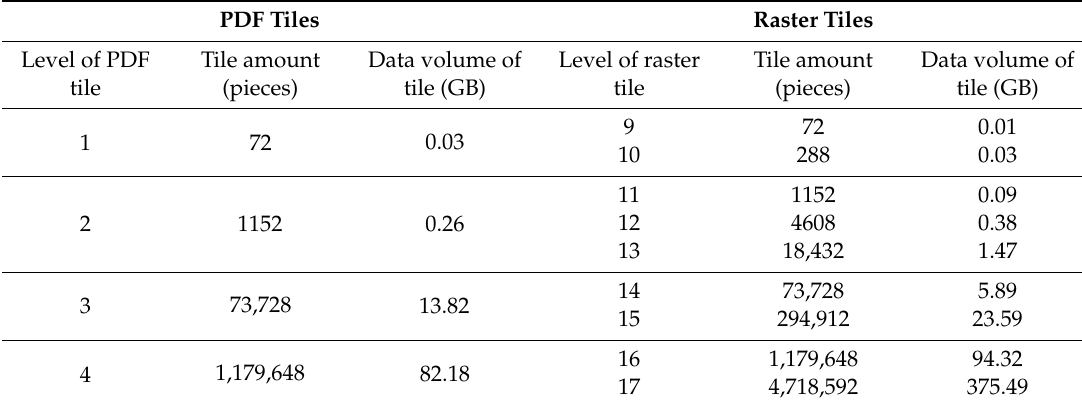
Table 3. PDF tile and raster tile data volume statistics.